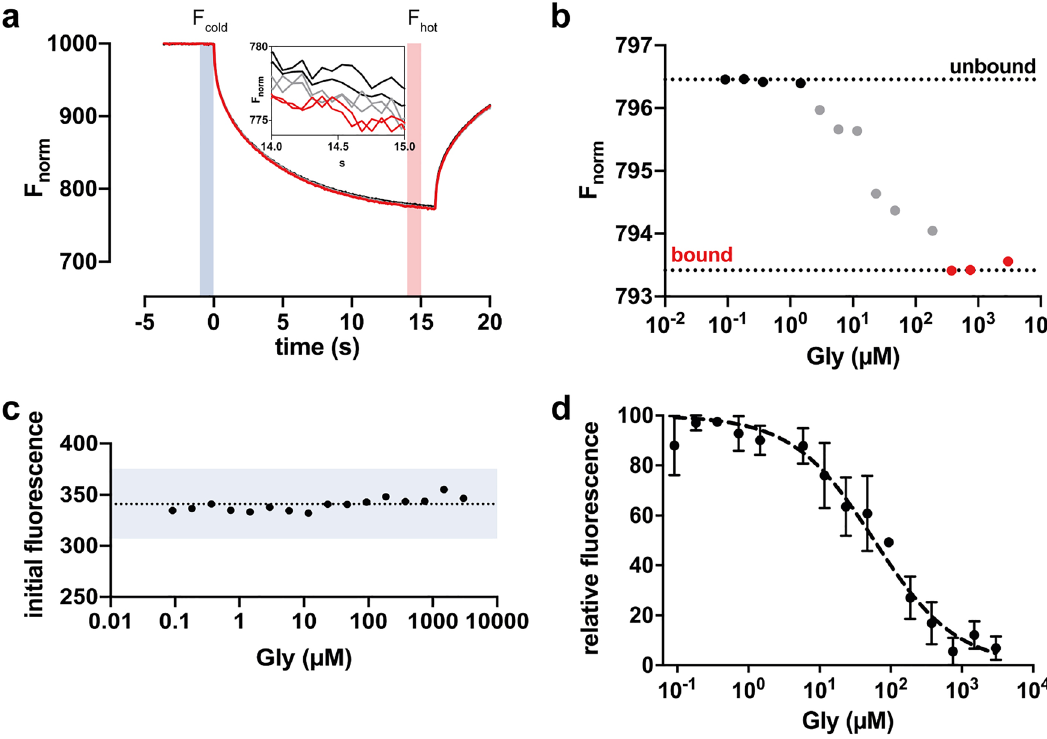
Figure 2. Functional characterization of SMA copolymer solubilized α1-His GlyR. ( a ) Example trace of primary thermophoresis data. Thermophoretic movement of α1-His GlyR nanodiscs is expressed as the change in fluorescence signal between initial fluorescence F cold (0 s) and fluorescence after thermodiffusion F hot (15 s) and was calculated as ratio of both values as described in the “Materials and Methods” section. Inset shows an amplification of representative fluorescence traces of the thermophoretic movement of the fluorescence labeled α1-His GlyR between 14 and 15 s (F hot ) obtained at different glycine concentrations [0 and 1 (black), 10 and 100 (gray) and 1000 and 3000 µM glycine (red)]. ( b ) The change in thermophoretic movement upon binding of increasing concentrations of Gly results in a change of the relative fluorescence between the unbound state (black) and glycine-bound state (red) after 15 s. ( c ) Initial fluorescence count distribution for each concentration is under 10% and showing no ligand-dependent fluorescence quenching. ( d ) Dose–response curve obtained from MST experiments of α1-His GlyR. Binding of glycine to fluorescence-labeled α1-GlyR was obtained with a titration series from 3 mM to 0.73 µM in PBS buffer, pH 7.4. The change in thermophoretic signal leads to a cEC 50 of 65 ± 22.8 µM. Error bars represent SEM between n = 3 independent